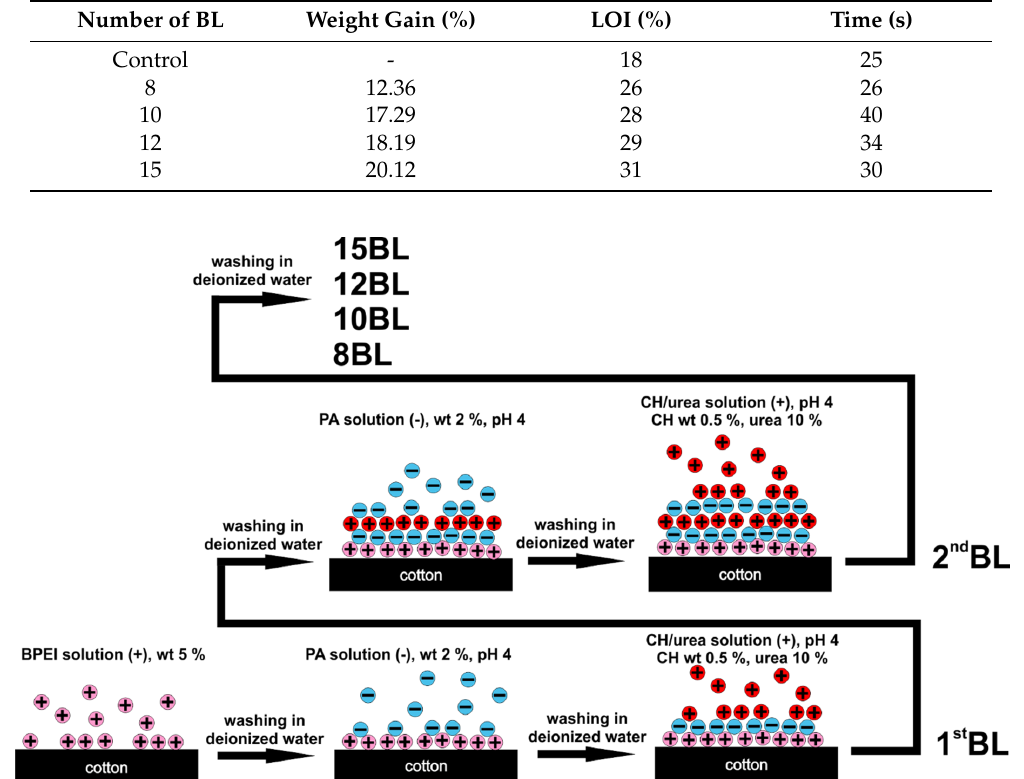
Figure 1. Schematic of layer-by-layer deposition of flame retardant nanocoatings on cotton fabric. Table 1. Weight gain and limiting oxygen index